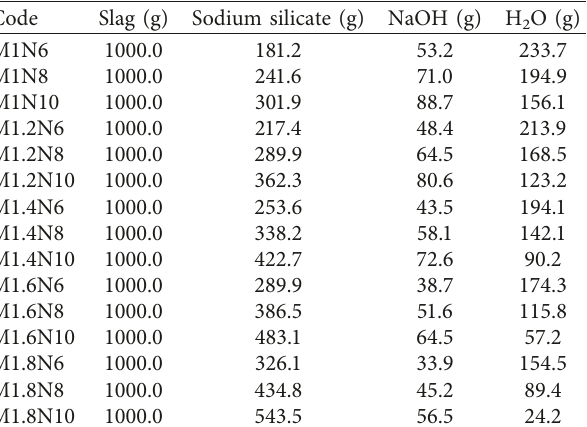
Table 2: The mixing proportions used for this study.